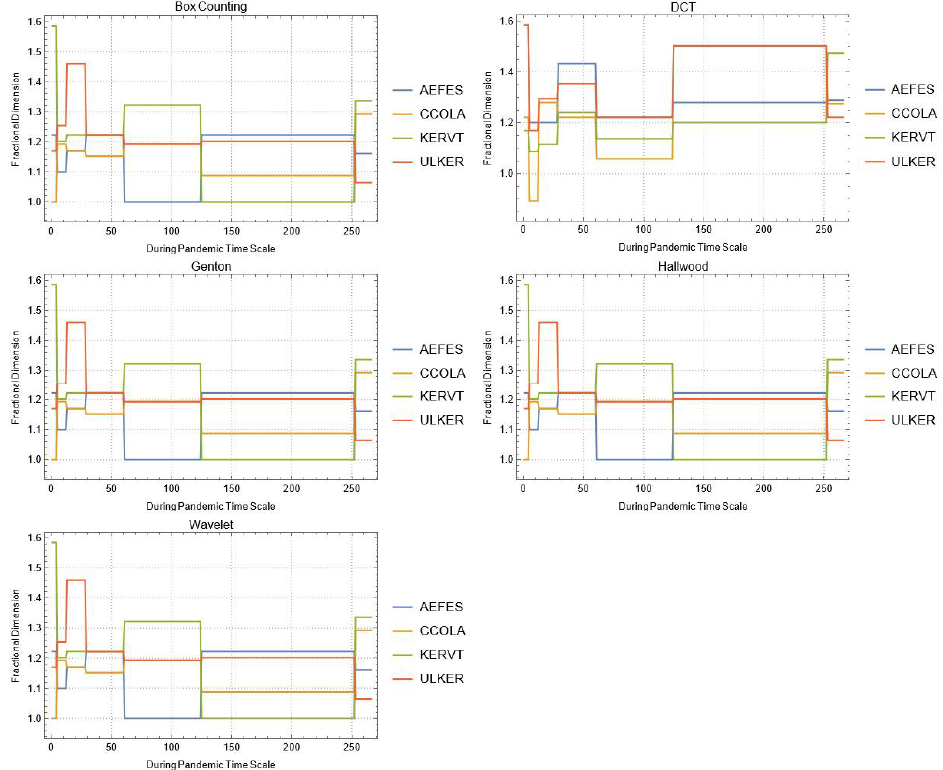
Figure A4. Daily changes of fractal dimensions during the pandemic (metal industry).